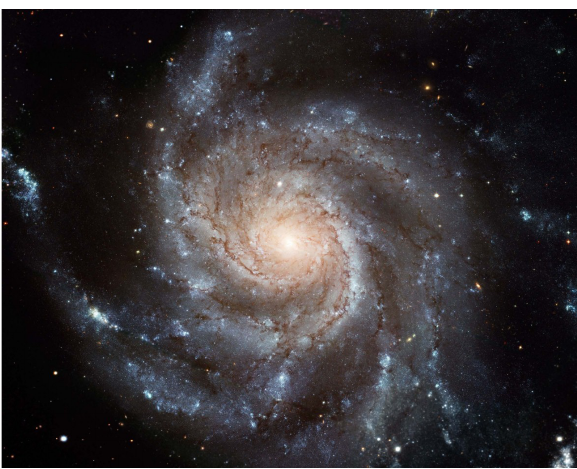
Figure 13. Hubble Space Telescope image of spiral galaxy, M101.